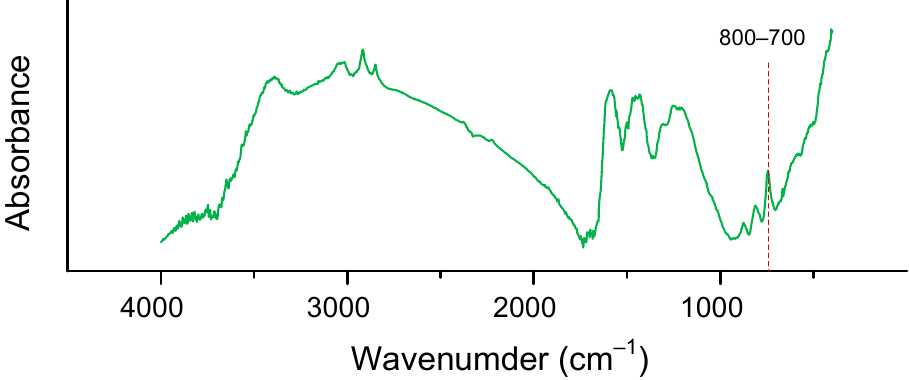
Figure 15. FTIR spectrum of the char residue of P-q-based polybenzoxazine.